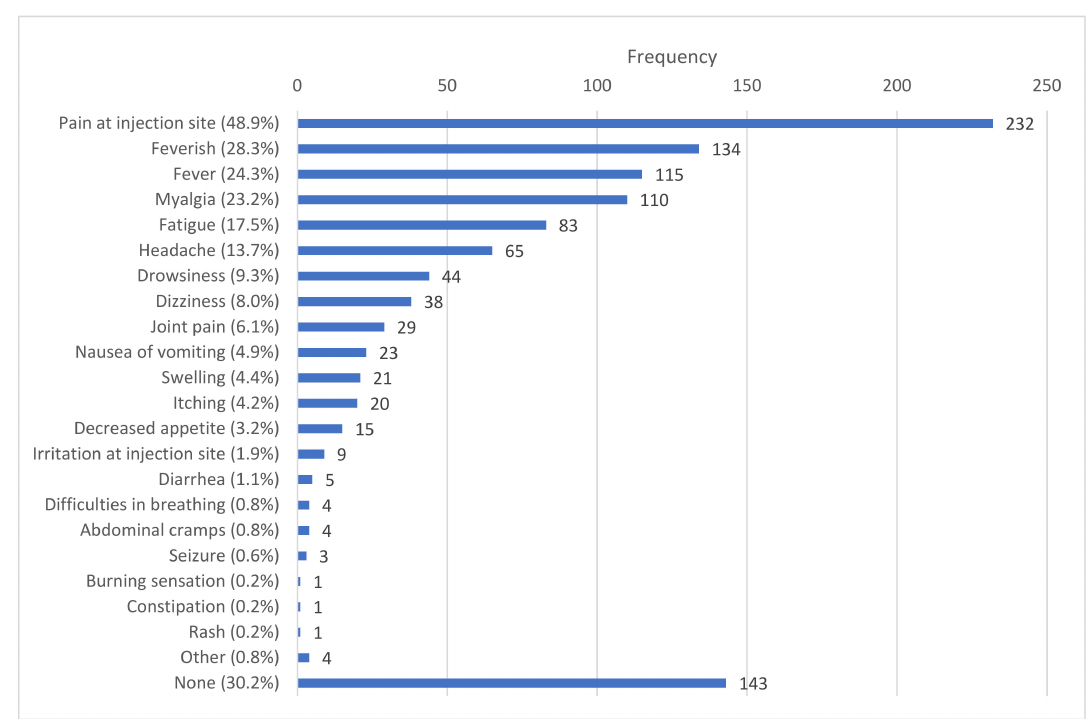
Figure 4. Reported side effects after the first dose of the Covishield vaccine. Pain at the injection site was the most common local side effect, while feeling feverish or having a fever seemed to be the most common systemic side effects. Thirty percent of participants reported having no side effects after their